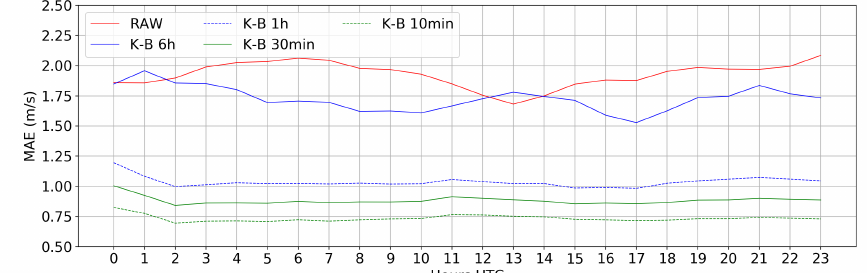
Figure 5. Wind speed MAE for all the turbines, hourly (moving average) for the entire 24 h simulation period with RAW outputs (red) and K-B model cases: K-B 6 h (blue), K-B 1 h (dotted blue), K-B 30 min (green) and K-B 10 min (dotted